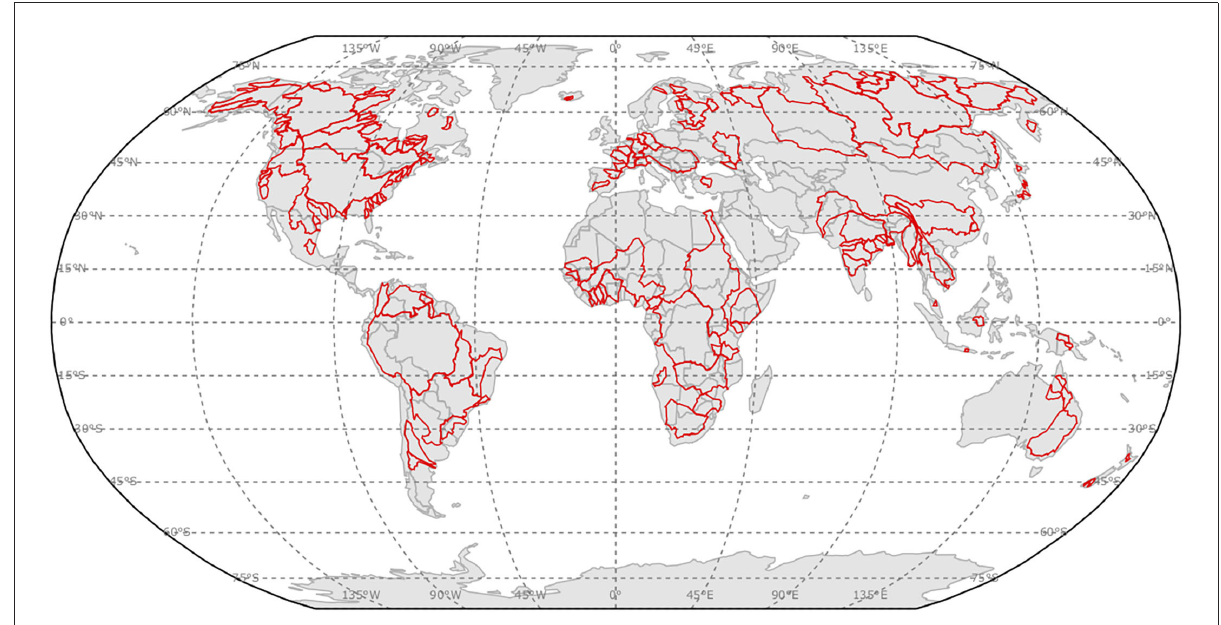
FIGURE1 The world map with catchments used in this study is outlined in